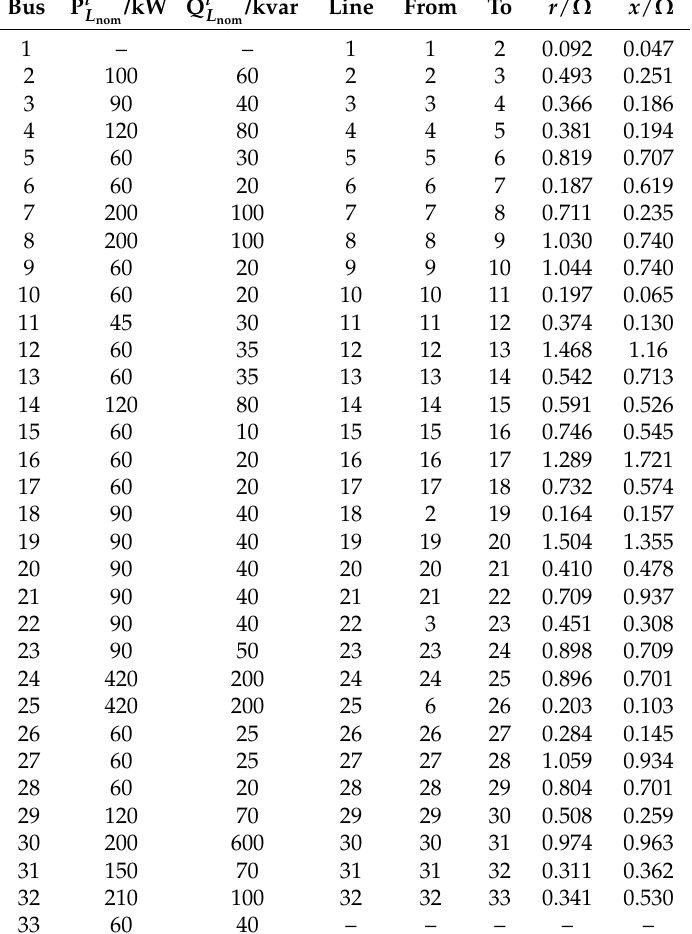
Table 1. Nominal active and reactive loads as well as line parameters of the IEEE 33-bus radial distribution